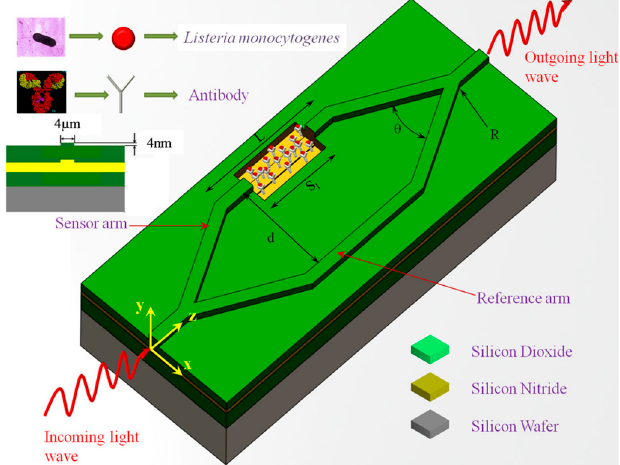
Figure 7. Schematic representation of biofunctionalization on Mach–Zehnder interferometer (MZI). Here, Sl is the length of the sensor area, L is the length of the sensor arm, d is the distance between the sensor and reference arms, and θ is the opening angle of the Y-divisor for angular Y-junctions, whereas R is the radius of curvature of the Y-divisor for S-bend Y-junctions. Reproduced with permission from [185]. Copyright © 2020, published by Springer Nature.